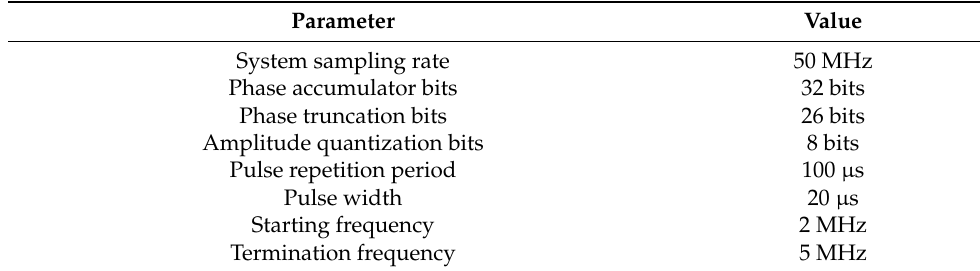
Table 4. Parameter of direct digital synthesizer.